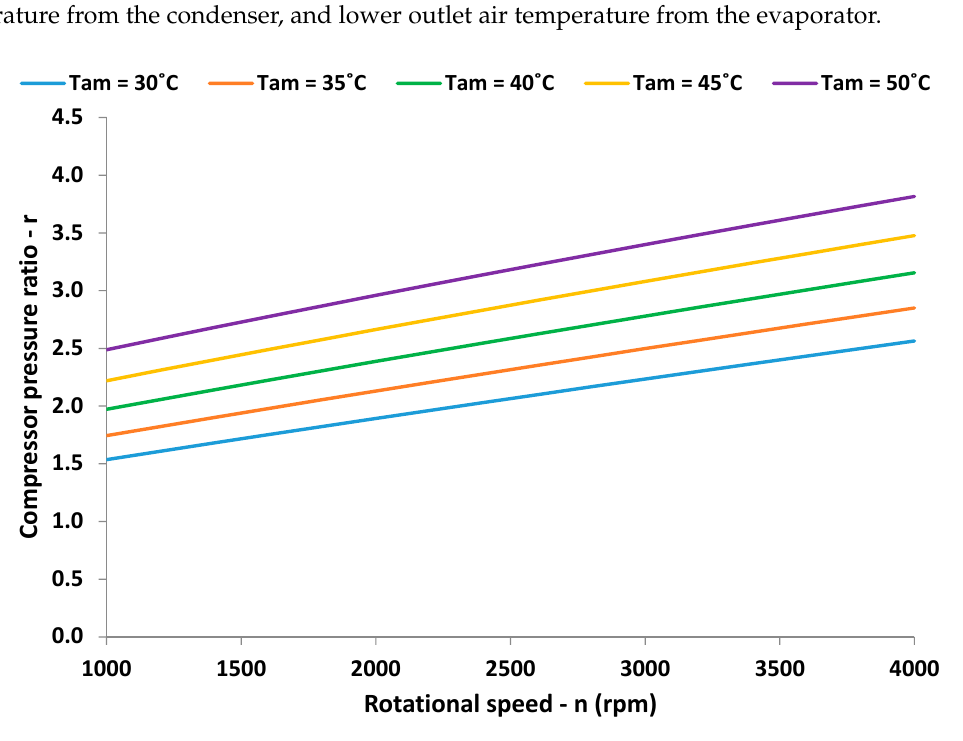
Figure 4. Compressor pressure ratio for different rotational speeds and ambient temperatures ( T ind = 25 °C).